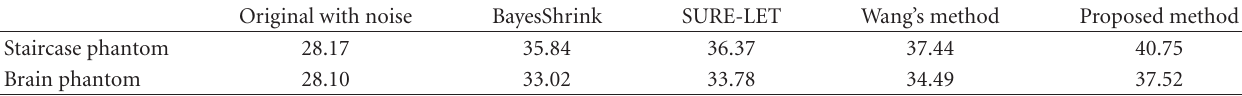
Table 1: PSNR of the phantom images in